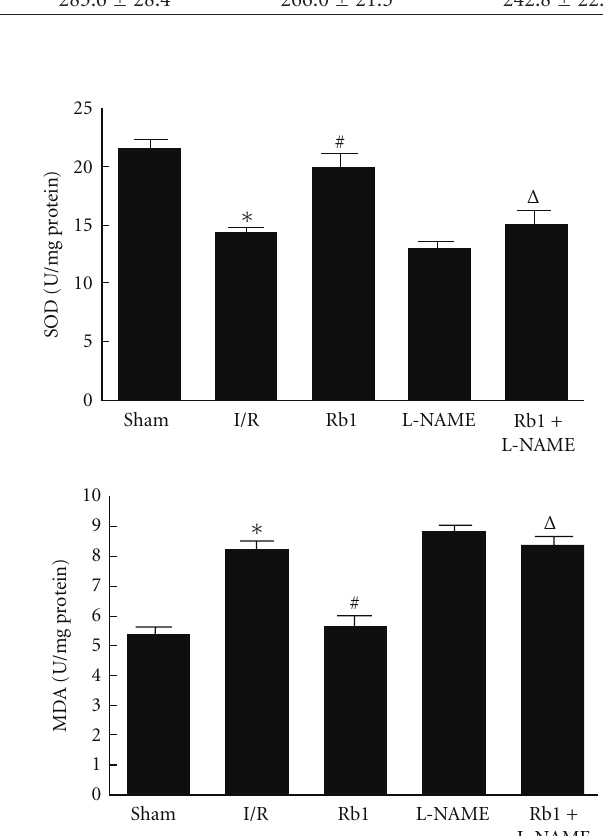
Figure 3: E ff ect of Ginsenoside Rb1 preconditioning on SOD and MDA. Results are expressed as mean ± SEM. ∗ P < 0 . 01 versus Sham group, # P < 0 . 05 versus I/R group, Δ P < 0 . 05 versus Rb1